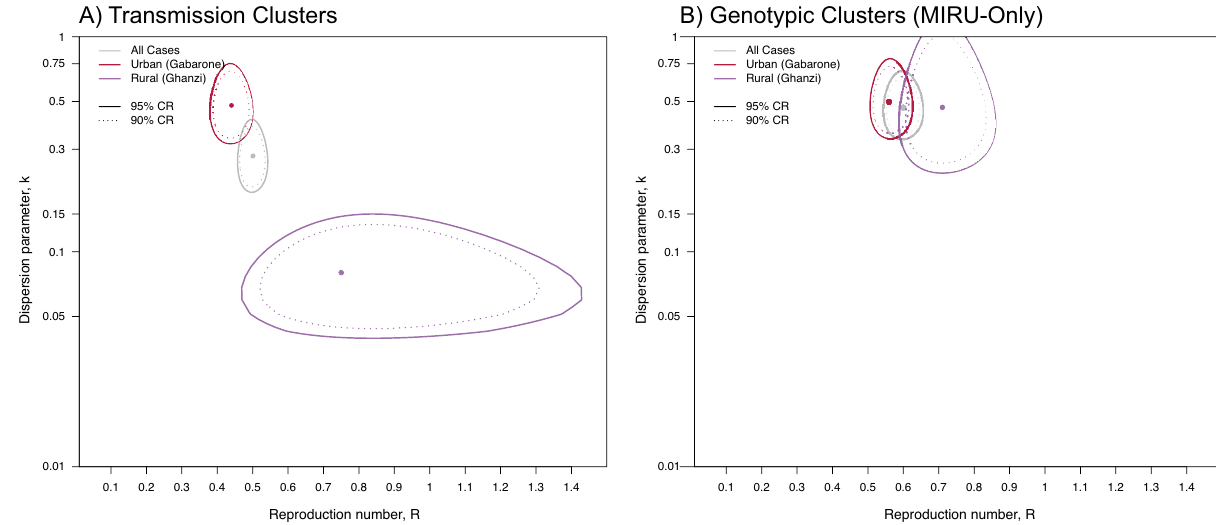
Figure 2. Joint maximum likelihood estimates (MLE) of transmission parameters R and k inferred from transmission cluster analysis. The use of geospatial and epi-link data to identify transmission sub-clustering reveals marked differences in transmission dynamics. ( A ) MLE and corresponding 90 and 95 percent confidence regions (CRs) using genotypic, geospatial, and epi-link data to identify transmission sub-clusters within a genetic cluster; ( B ) Values under the assumption that MIRU-VNTR genotypic clusters are transmission clusters. This assumption biases results towards homogeneity and provides functional upper bound estimates of k